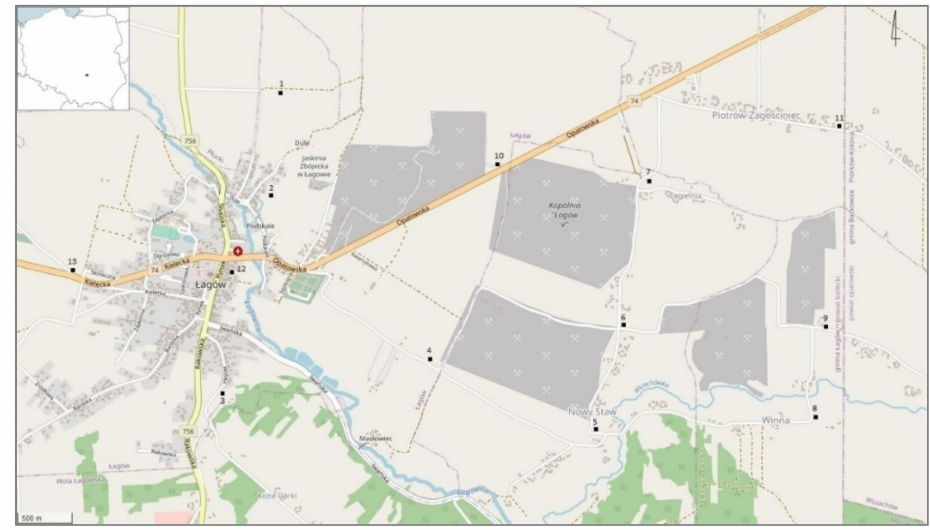
Figure 1. Study area with sample points number (developed on the basis of OpenStreetMap